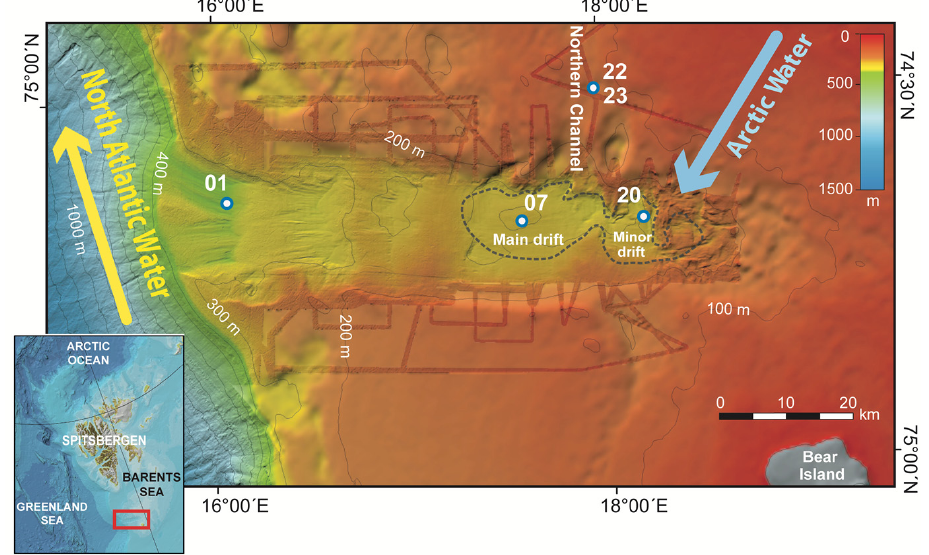
Figure 1. Bathymetric map of the Kveithola Trough in the Barents Sea and sampling sites. Dotted lines evidence the outer and inner areas of the Kveithola Trough that are deeper and shallower than 300 m wd, respectively. The inset indicates the studied area located south of Svalbard. This figure modified after Figure 1 in [16].